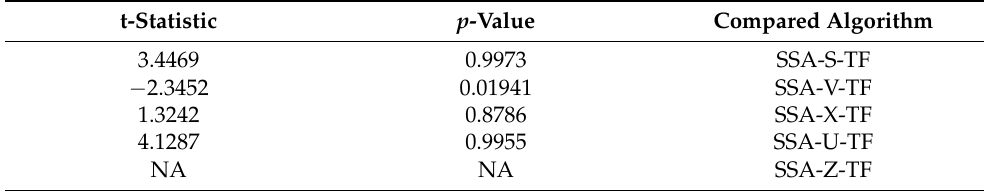
Table 2. The results of statistical testing of the t -test type based on the accuracy metric of the SSA-new V-TF algorithm as the best optimization algorithm with SSA-S-TF, SSA-V-TF, SSA-X-TF, SSA-U-TF and SSA-Z-TF algorithm.